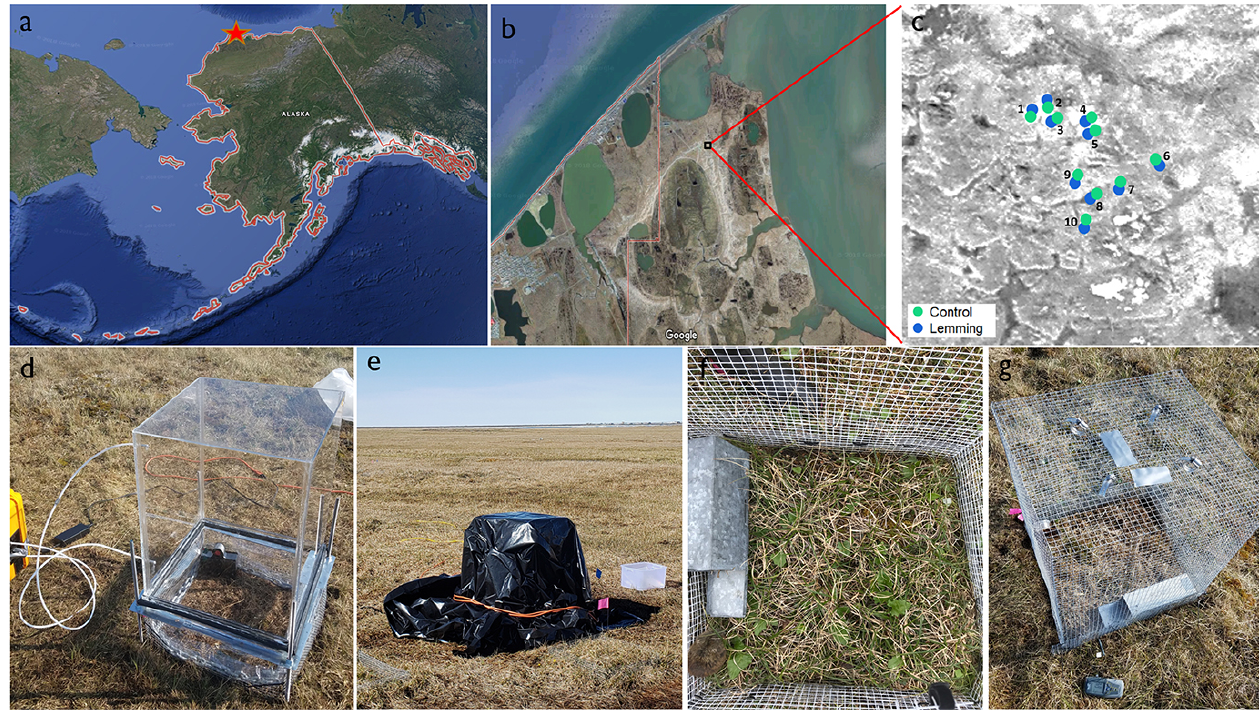
Figure 1. (a) The location of the study site, Utqia˙gvik (Barrow), in Alaska (© Google Maps 2018, imagery from TerraMetrics) represented by a red star, (b) location of the sampling site (© Google Maps 2018, imagery from TerraMetrics), (c) distribution of the sampling plots on an image created using the coordinates of the plots in the statistical program R (Worldview-3 panchromatic imagery taken 24 July 2016, Maxar Technologies), (d) chamber used for the greenhouse gas flux measurements, (e) chamber covered by light-blocking material, and (f, g) enclosures installed at each of the plots during the manipulation